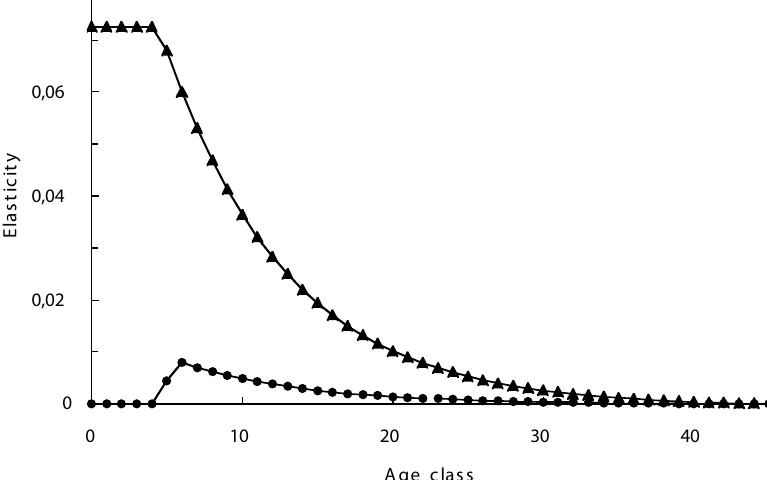
Fig. 9. Elasticities of lambda to changes in survival and fecun - dity of each age class in an age structured model. It is evident that changes in survival (trian - gles) have the largest effect on λ, especially during the first 10 years. After age 5 or so the elas - ticities of lambda to changes in survival decrease monotonically. The importance of fertility values (circles) is much smaller and peaks at about 6 years whereafter it decreases